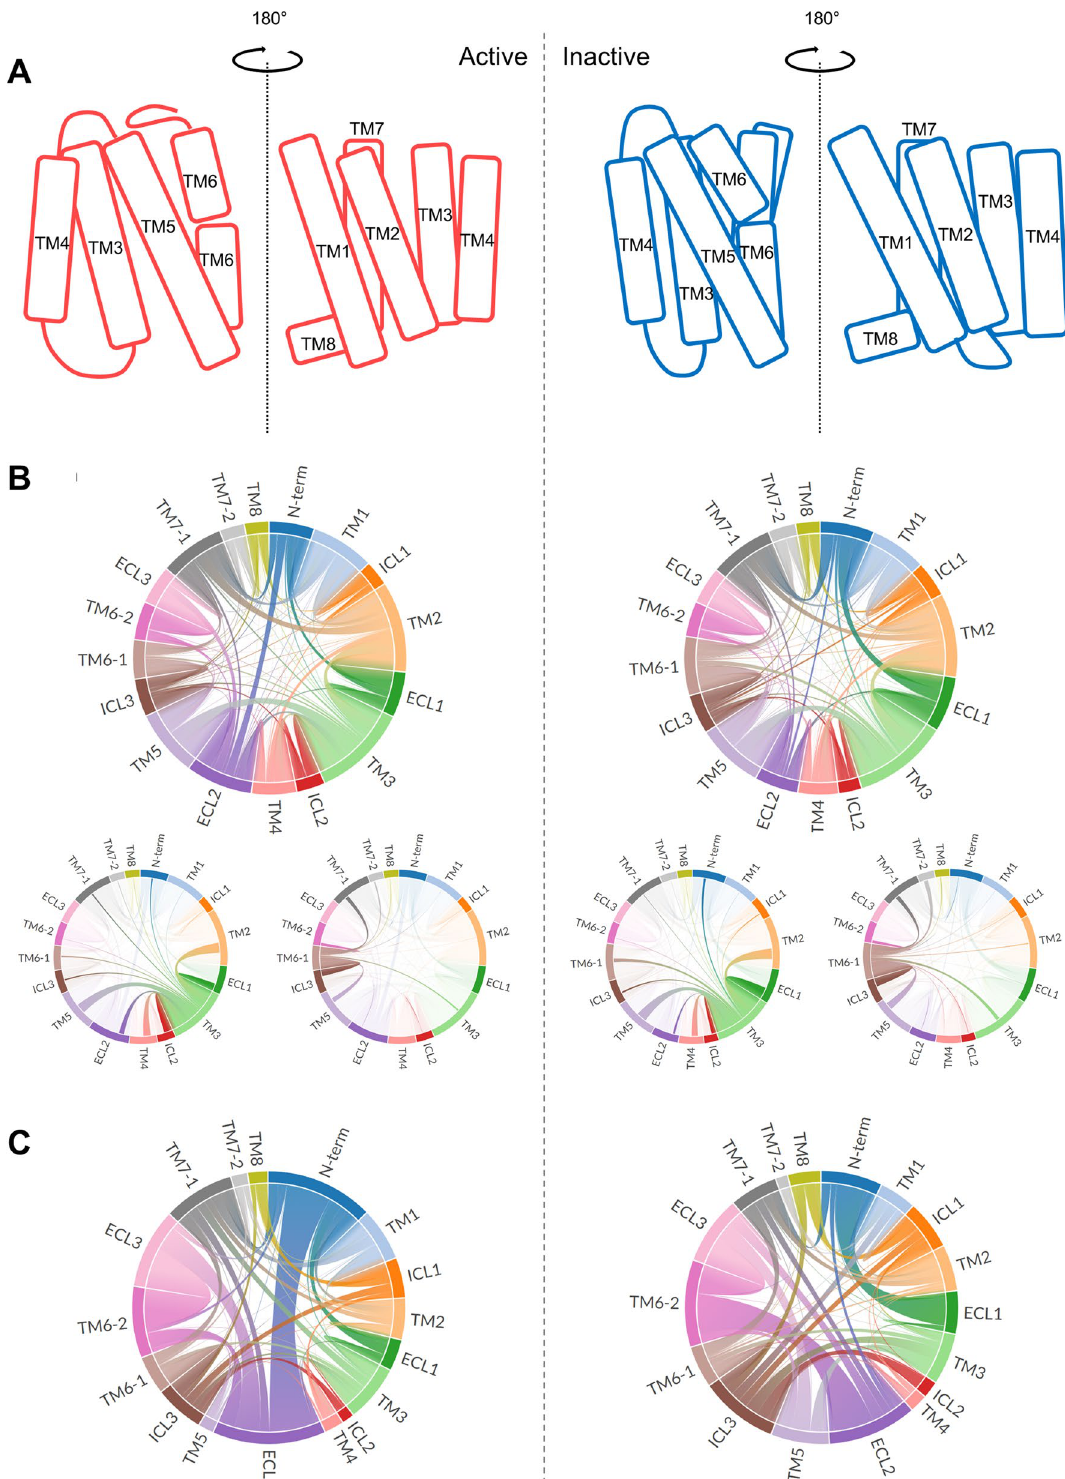
Figure 4. The interaction energies among helices and loops of CB1. ( A ) Simplified relative position of helices for active and inactive CB1. ( B ) The pairwise interaction among helices and loops of wildtype CB1. Especially, the pairwise interactions for TM3 and TM6 in which the toggle switch is located are separately presented. ( C ) The energetic changes for pairwise interaction after the